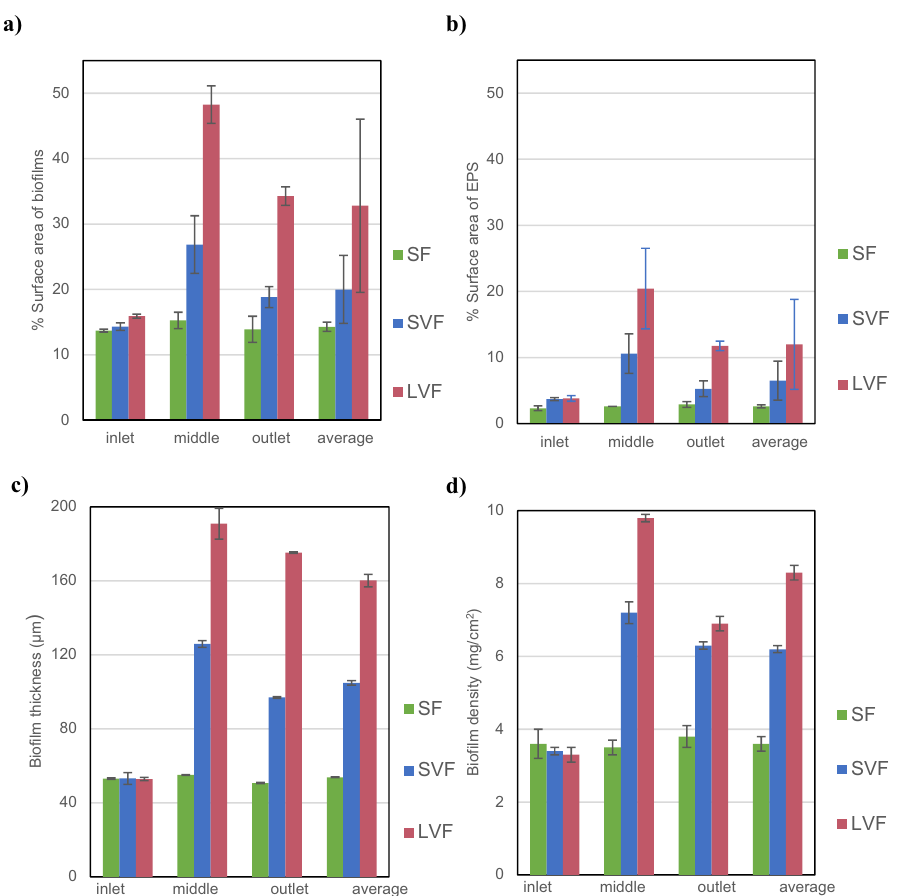
Fig. 4 Characteristics of the bio fi lms that accumulate on the slides on the channel walls for experiment set 1 at three different locations, inlet, middle and outlet, and the average across the whole wall. a The percentage of the slide covered with bio fi lm. b The percentage covered by EPS alone. c The bio fi lm thickness. d The bio fi lm density. Note the spatially average density and thickness weighted to the values in areas where the coverage is highest. The error bars in the histrograms represent + /- one standard coverage of bio fi lm (Fig. 5a) and the EPS in isolation (Fig. 5b) tap water that fed the two experimental sets was signi fi cantly measured for the LVF was signi fi cantly higher in the second set different: means 5.2 × 10 5 and 8.1 × 10 5 cells/ml and standard deviations 0.7 × 10 5 and 1.1 × 10 5 cells/ml for experiment sets 1 experiments than in the fi rst (Fig. 4), even though the and 2 respectively. The higher density of bacteria in the second experimental setup was identical, however, the thickness (Fig. experimental set may re fl ect the fact that the fi rst and second sets 5c) and density (Fig. 5d) were similar between the two experiment of experiments were conducted at different times. The sets. This merely re fl ects the fact that the density of bacteria in the